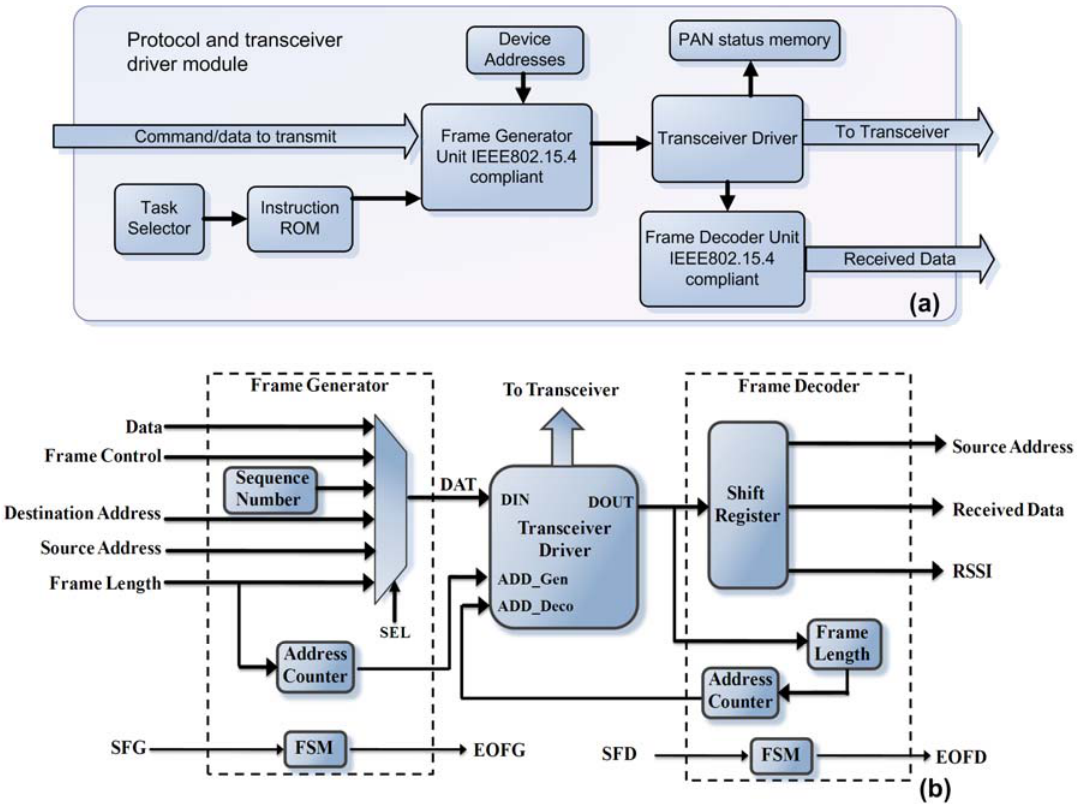
Figure 3. Block diagram of (a) the protocol architecture, (b) frame-generator and frame-decoder modules